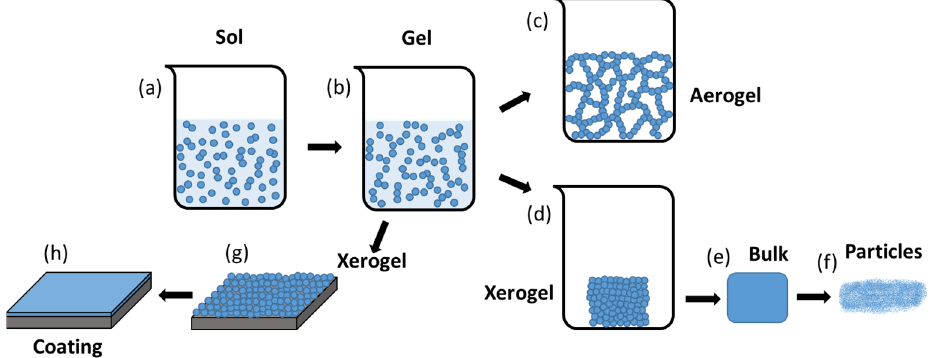
Figure 2. Sol-gel synthesis process (sol ( a ) to gel ( b )) and generation of ceramic materials (aerogel ( c ), and xerogel ( d , g )) with different morphologies (coating ( h ), bulk ( e ), and particles ( f )). Adapted from C.J. Brinker et al. [15].